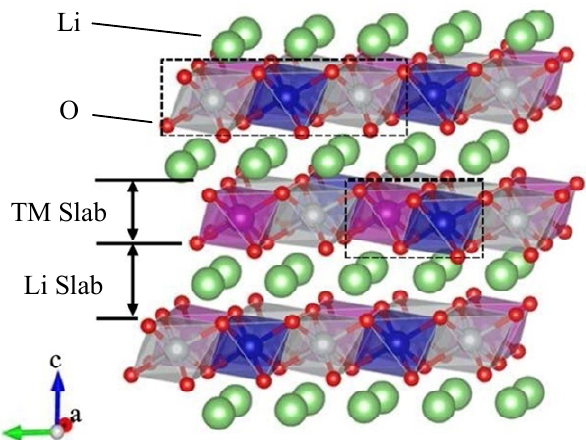
Figure 4. Crystal structure of NCM cathode. The gray, blue and purple spheres represent Ni, Co and Mn atoms in the transmission metal (TM) layer, respectively, and the red sphere represents O atoms [28].